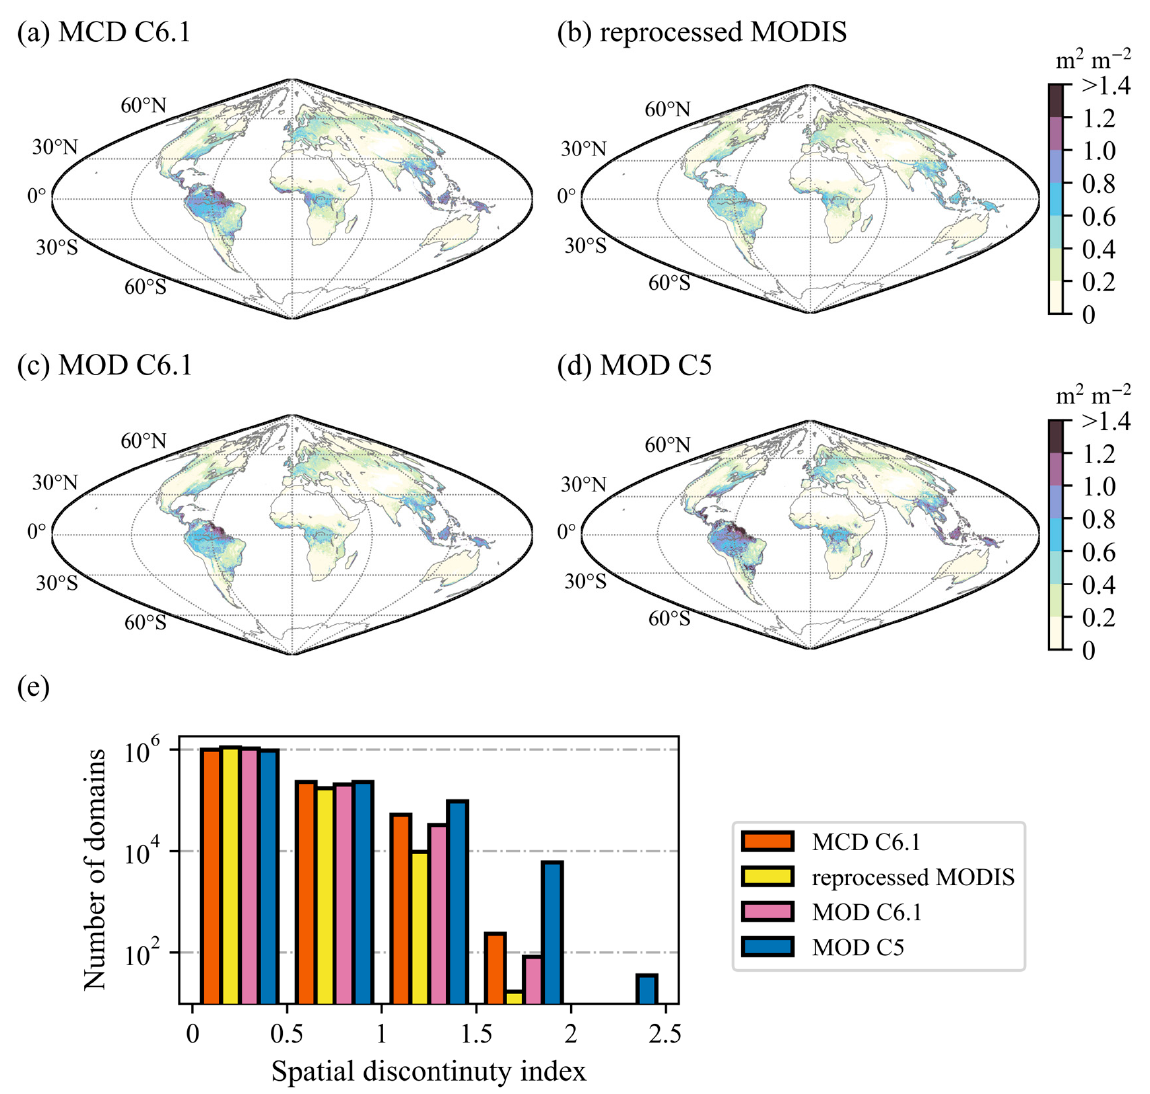
Figure 5. 14-year (2003–2016) means of spatial discontinuity index (SDI) maps of ( a ) MCD15A2H C6.1, ( b ) reprocessed MODIS, ( c ) MOD15A2H C6.1, ( d ) MOD15A2H C5 LAI products, and ( e ) the numbers of domains in SDI maps over different